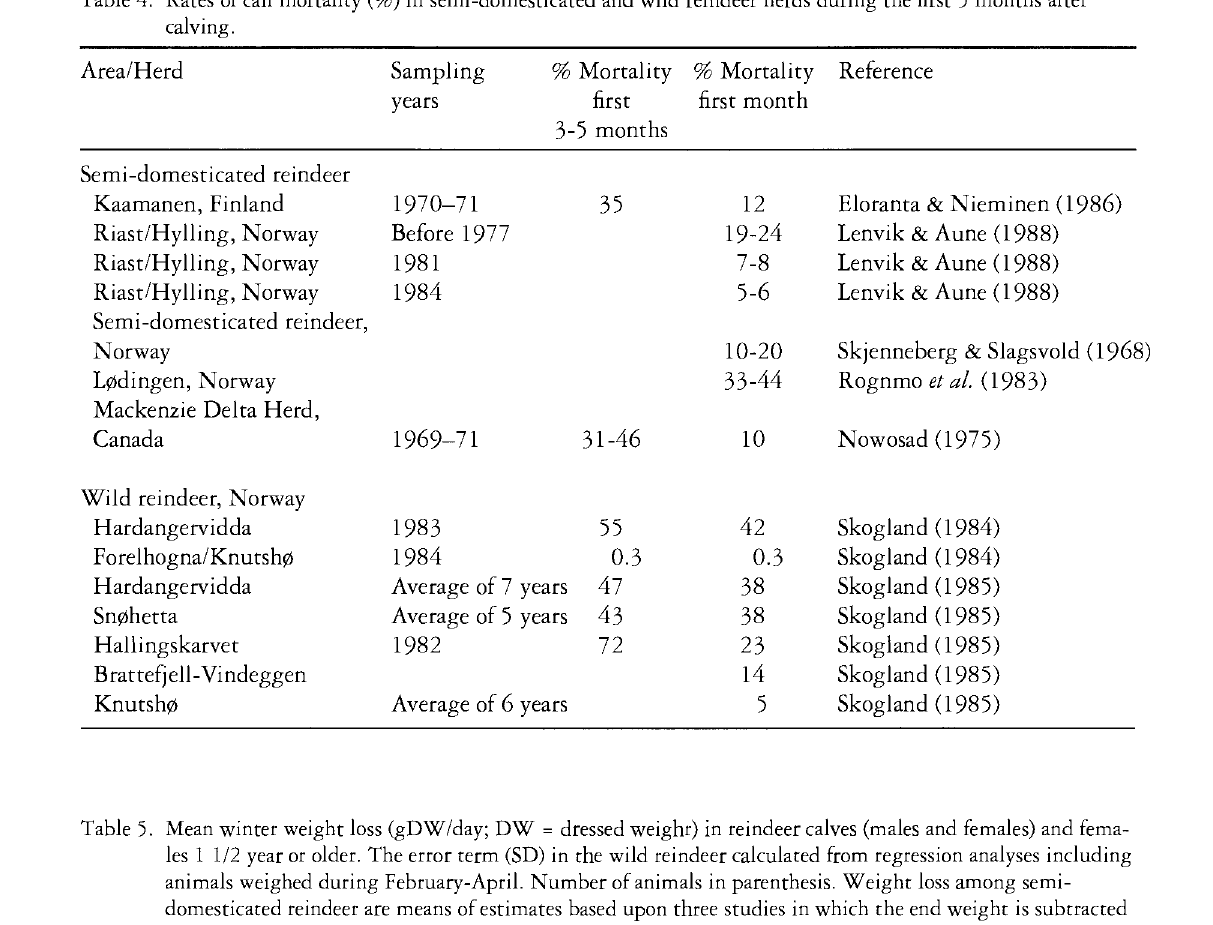
Table 4. Rates of calf mortality (%) in semi-domesticated and wild reindeer herds during the first 5 months after calving.